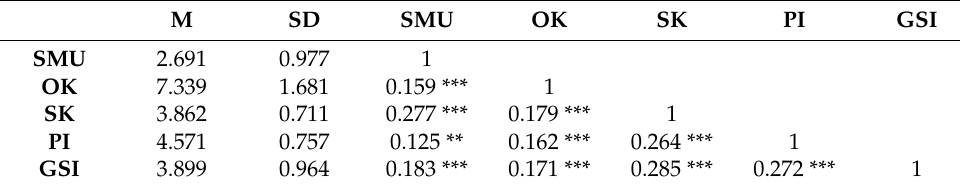
Table 1. Descriptive statistics and correlation coefficients of key variables. M SD SMU OK SK PI GSI SMU 2.691 0.977 1 OK 7.339 1.681 0.159 *** 1